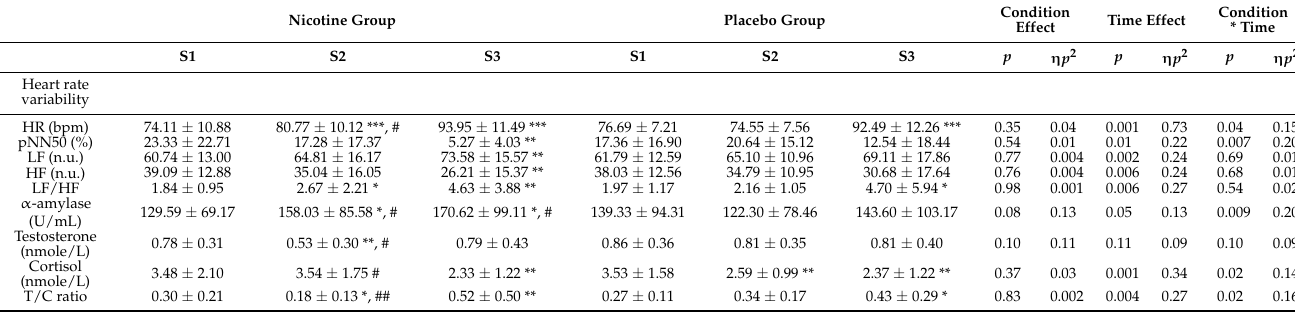
Table 2. The heart rate variability (HRV), and the levels of testosterone, cortisol and T/C ratio at different stages of both groups. PlaceboGroup